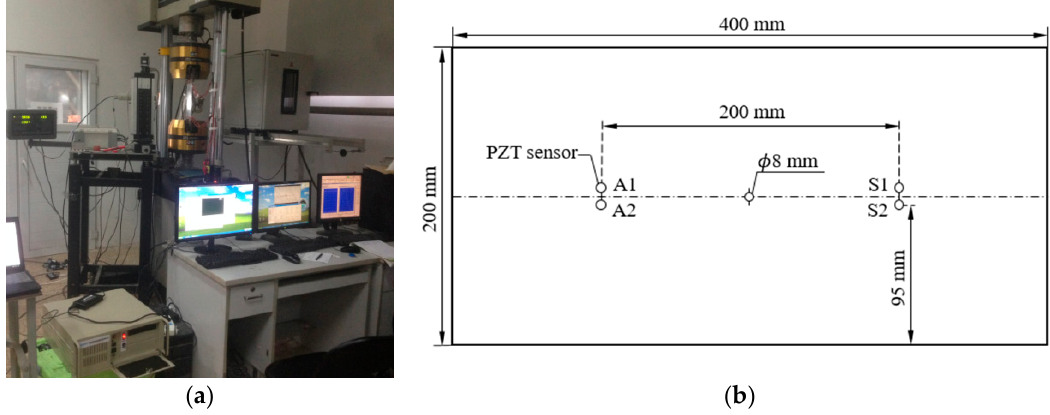
Figure 8. ( a ) Experimental setup of fatigue testing; and ( b ) schematic diagram of specimens and